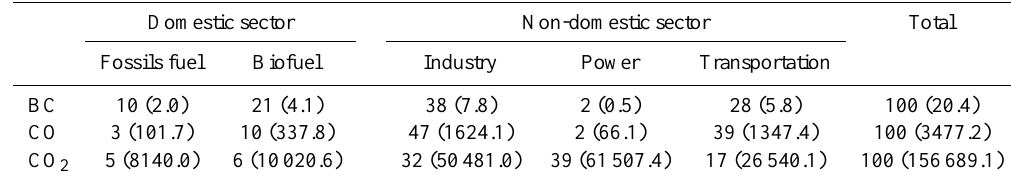
Table 1. Relative contributions (in %) of BC, CO, and CO 2 emissions from different sources in Guangzhou urban area (21.75 ◦ –24.25 ◦ N, 112.25 ◦ –114.75 ◦ E) for the year 2000 (Streets et al., 2003).